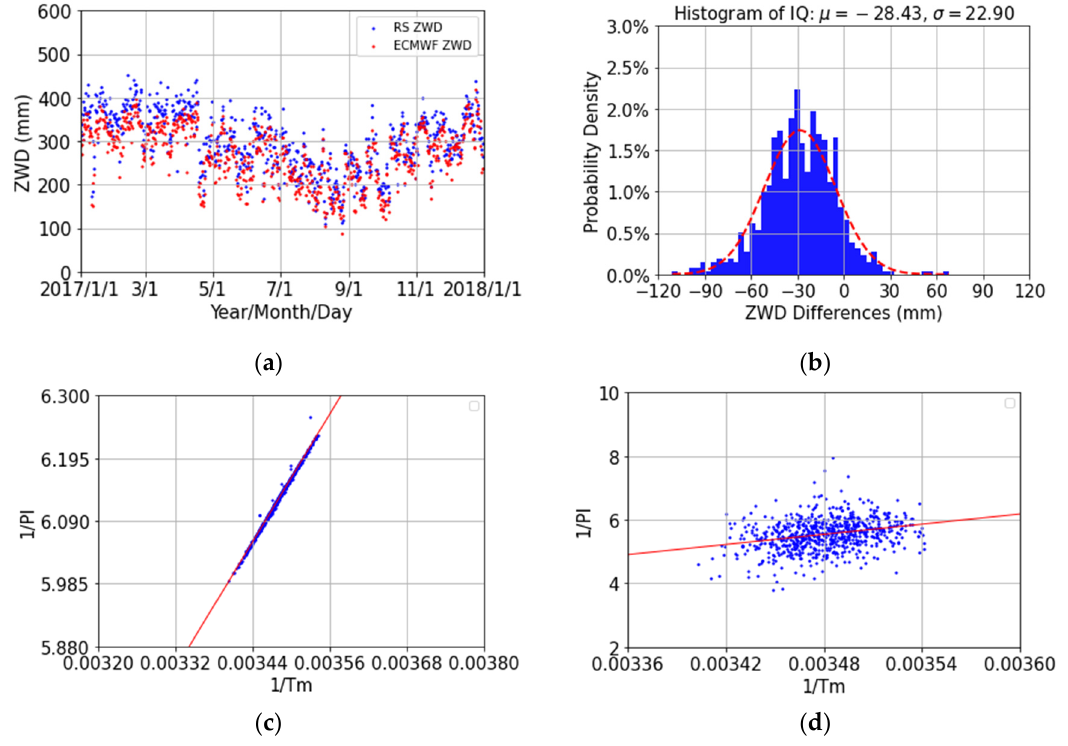
Figure 5. ( a ) FAA1 station: comparison between our RS-ZWD estimates (blue dots) with the ZWD estimates from VMF1/ECMWF (red dots); ( b ) histogram of the ZWD differences between the RS- ZWD values and the VMF1/ECMWF-ZWD values; ( c ) relationship between 1/ Π (1/ P 1 for the y -axis, RS-ZWD/RS-PW) and 1/ T m (for the x -axis, RS − T m ), and their least-squares linear fit: 1/ Π = 1779.61 ∗ 1/ T m − 0.07, with R 2 = 99.78% (red line); ( d ) relationship between 1/ Π (1/ P 2 for the y -axis, GPS-ZWD (VMF1/ECMWF)/RS-PW) and 1/ T m (for the x -axis, RS − T m ), and their least-squares linear fit: 1/ Π = 5322.56 ∗ 1/ T m − 12.98, with R 2 = 28.38% (red line). Table 5. Statistical summary for the comparison between RS-ZWD and VMF1/ECMWF-ZWD (VMF1/ECMWF minus RS-ZWD) in terms of max, min, bias, STD, and